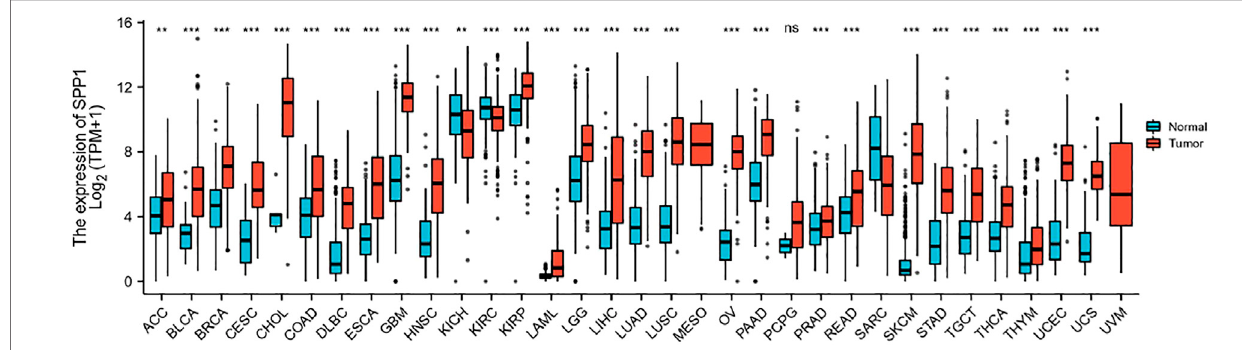
FIGURE 1 | SPP1 expression in normal and tumor tissues in TCGA and GTEx databases.